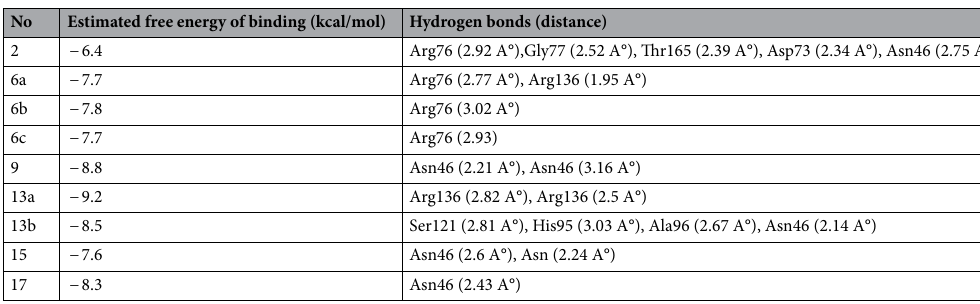
Table 1. Energy-based interactions and hydrogen bonds of arylthiourea derivatives docked into DNA gyrase.